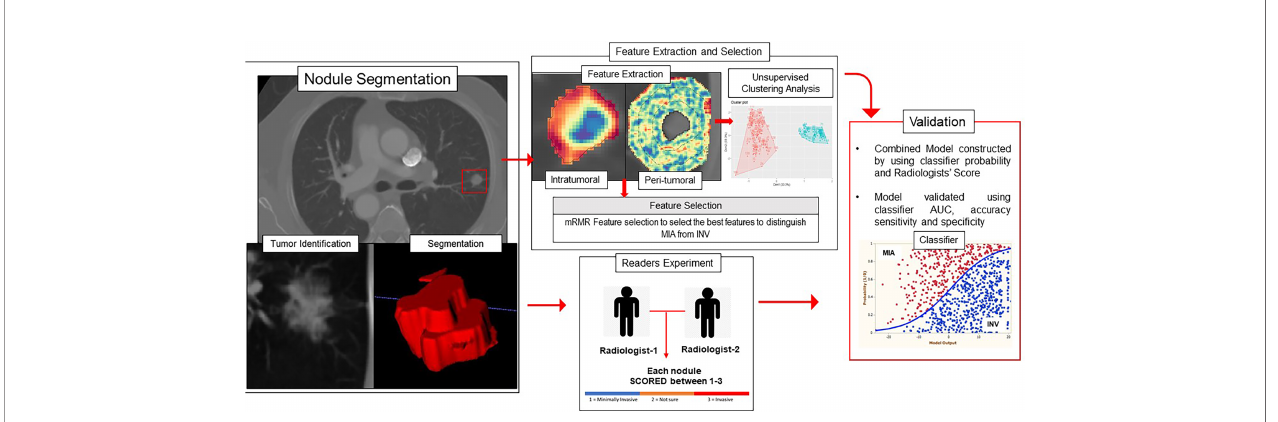
FIGURE 1 | Overall work fl ow diagram. The nodules were segmented on the CT scans, and intratumoral and peritumoral features were extracted using MATLAB 2015. The top features were selected using the mRMR feature selection method. The validation of the radiomics model was performed using unsupervised clustering and supervised classi fi cation-based approaches.